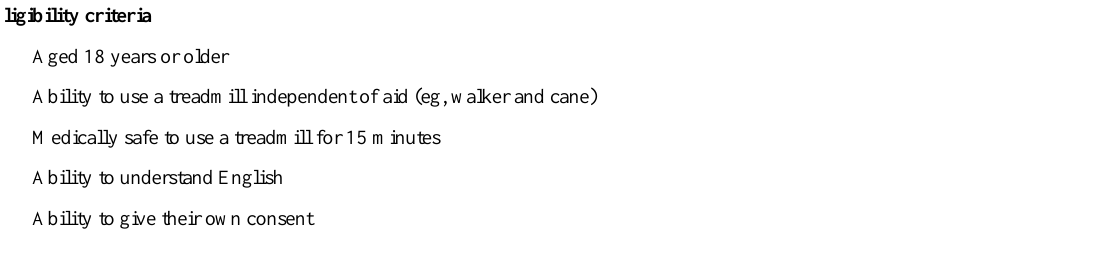
Textbox 1. Eligibility criteria for participation in